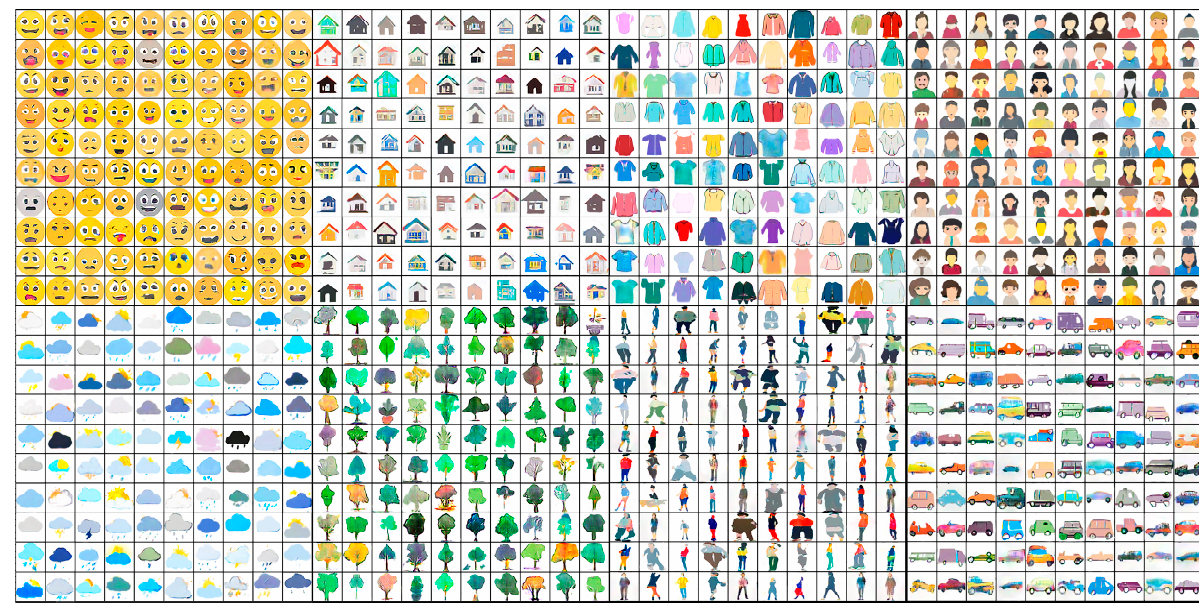
Figure 5. The generation effect of the model at the 50th epoch, and the StyleGAN with the conditional constraints is able to perform the icon generation task by category.